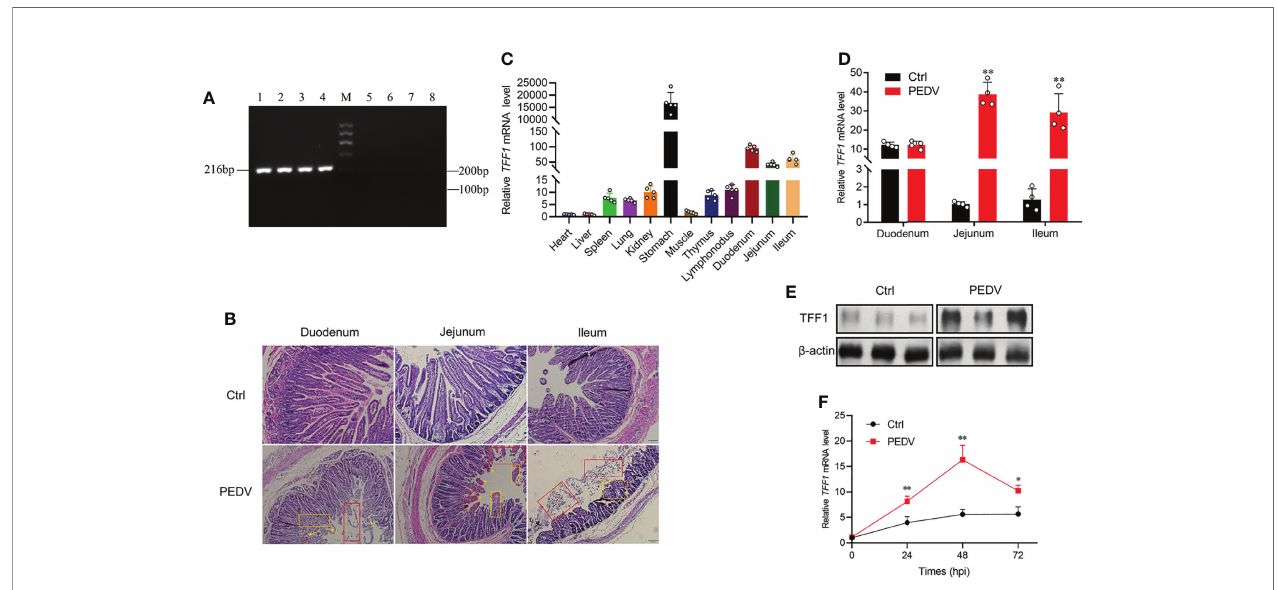
FIGURE 1 | TFF1 is a key candidate responsible for PEDV infection. (A) RT-qPCR detection of M gene expression by 2.0% agarose gel electrophoresis. Lanes 1-4, intestinal contents of diarrhea piglets; Lane M, Marker I marker; Lanes 5-8, intestinal contents of control piglets. (B) Paraf fi n sections microscopy of duodenum, jejunum, and ileum tissues (100×). Different symbols in the pictures represented different pathological symptoms; yellow arrows represented congestion in the lamina propria, yellow boxes represented in fi ltration of in fl ammatory cells, and red boxes represented breakage and shedding of epithelial cells in the intestinal mucosa. (C) Porcine tissue expression distribution of TFF1 in 11 tissues. (D) Differential expression of TFF1 gene in duodenum, jejunum, and ileum. (E) Western blotting analysis of TFF1 protein level in jejunum. b -actin was used as internal reference proteins. (F) IPEC-J2 were infected with PEDV at MOI of 0.1. Cells were collected at 24, 48, and 72 hours post infection and detected mRNA expression of TFF1 by RT-qPCR. Data are presented as mean values ± SD, using two tailed Student ’ s t-test . * p < 0.05, ** p < 0.01. Each treatment has triplicate biological replicates at least.